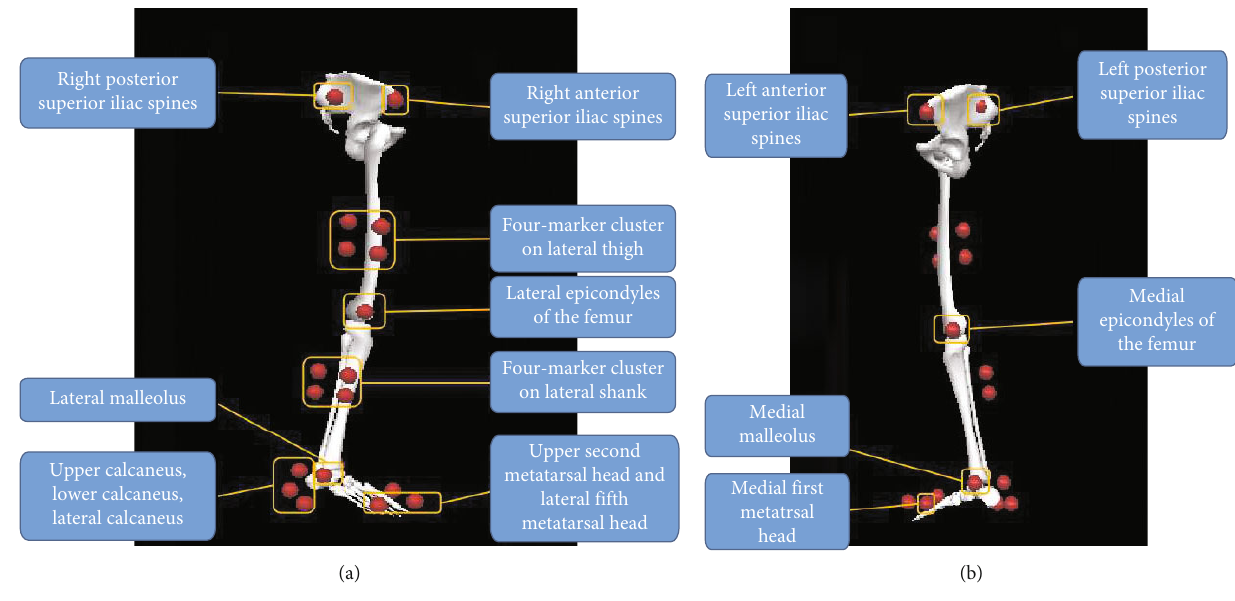
Figure 3: Re fl ective markers scheme: (a) right view; (b) left